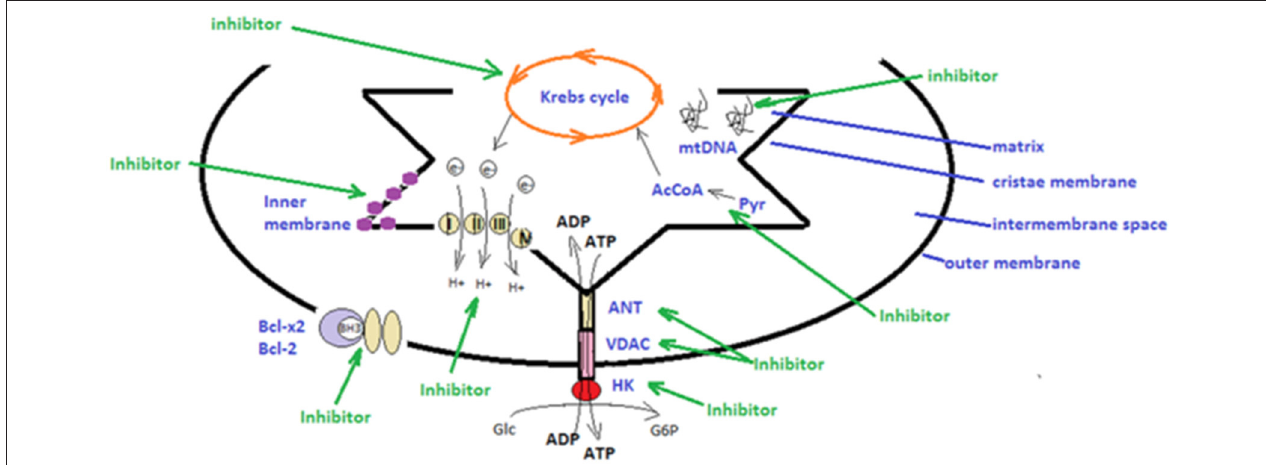
FIGURE 1 | Schematic presentation of strategies utilized in mitochondrial therapeutic targeting. There are several types of mitocans that can target components appending to the outer mitochondrial membrane, to the inter-membrane space, to the cristae membrane and to the matrix. Hexokinase (HK), voltage-dependent anionic channel (VDAC) and adenine nucleotide translocase (ANT) can be targeted by inhibitors that will disrupt main metabolic pathways and the anti-oxidative potential of tumor cells (48, 106, 129); The mitochondrial electron transport chain, producing energy by transporting electrons can be targeted by specific inhibitors (131, 132); BH3 mimetics can impair the function of the anti-apoptotic Bcl-2 and Bcl-x2 family proteins (76, 127); lipophilic cations can directly target the mitochondrial inner membrane and hinder mitochondrial transmembrane potential; compounds that affect directly the tricarboxylic acid cycle (Krebs cycle), affect the electrons stream into the electron transport chain ( 133); inhibitors that target the conversion of pyruvate (Pyr) to acetyl-CoA (AcCoA) hinder the tricarboxylic acid cycle (67); inhibitors that interfere with the mitochondrial DNA (mtDNA) affecting DNA polymerases or transcript levels (46, 83) (green